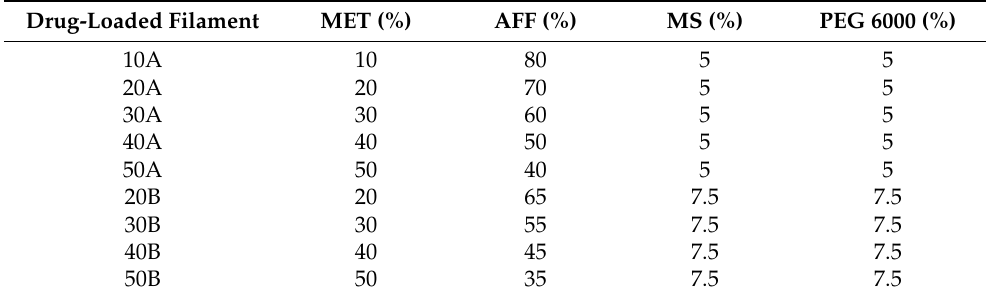
Table 1. Composition of the drug-loaded filaments. The letter (A/B) refers to the concentration of both auxiliary excipients (MS and PEG 6000), A corresponding to 5% each and B to 7.5% each. Drug-Loaded Filament MET